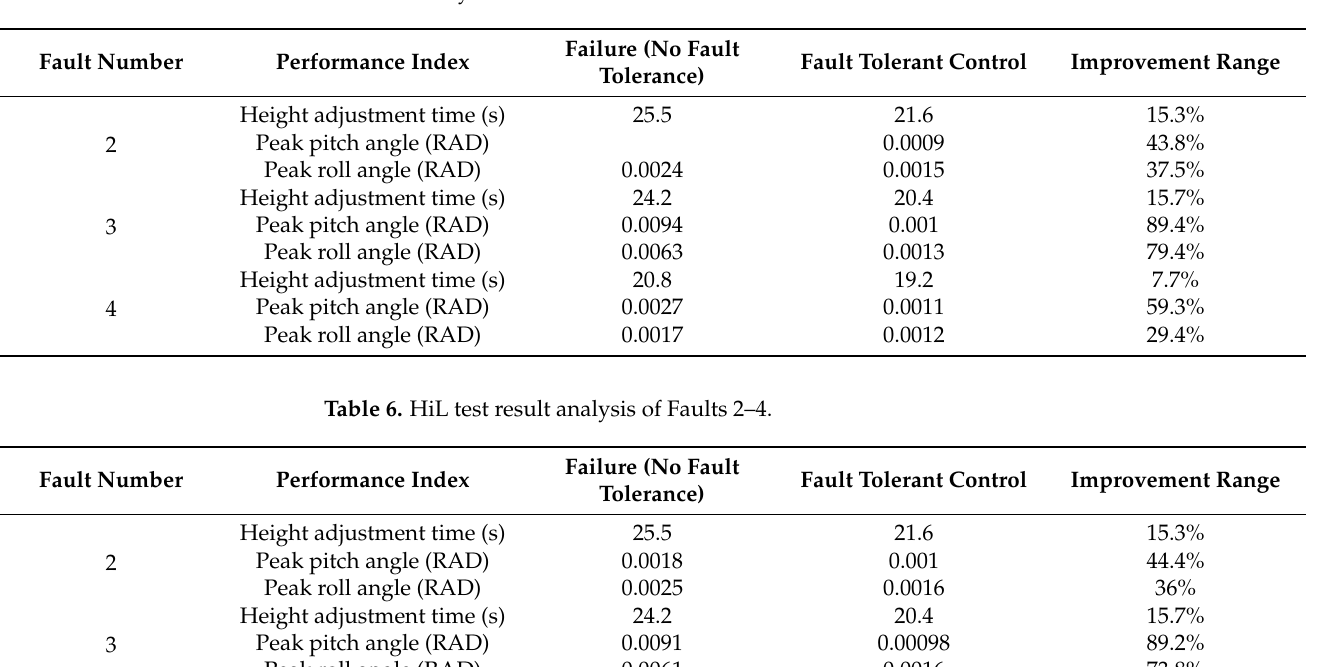
Table 5. Analysis of simulation results of Faults 2–4.